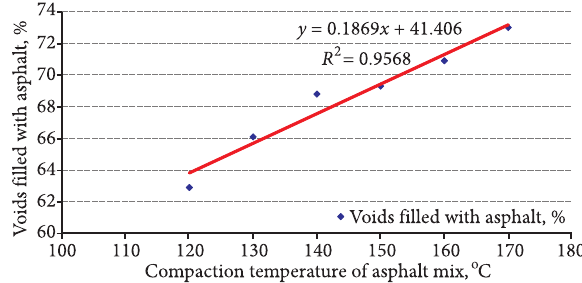
Fig. 8. Dependence of compaction temperature and voids filled with asphalt Table 2. Correlations of properties of asphalt mixtures and compaction temperatures Mixture